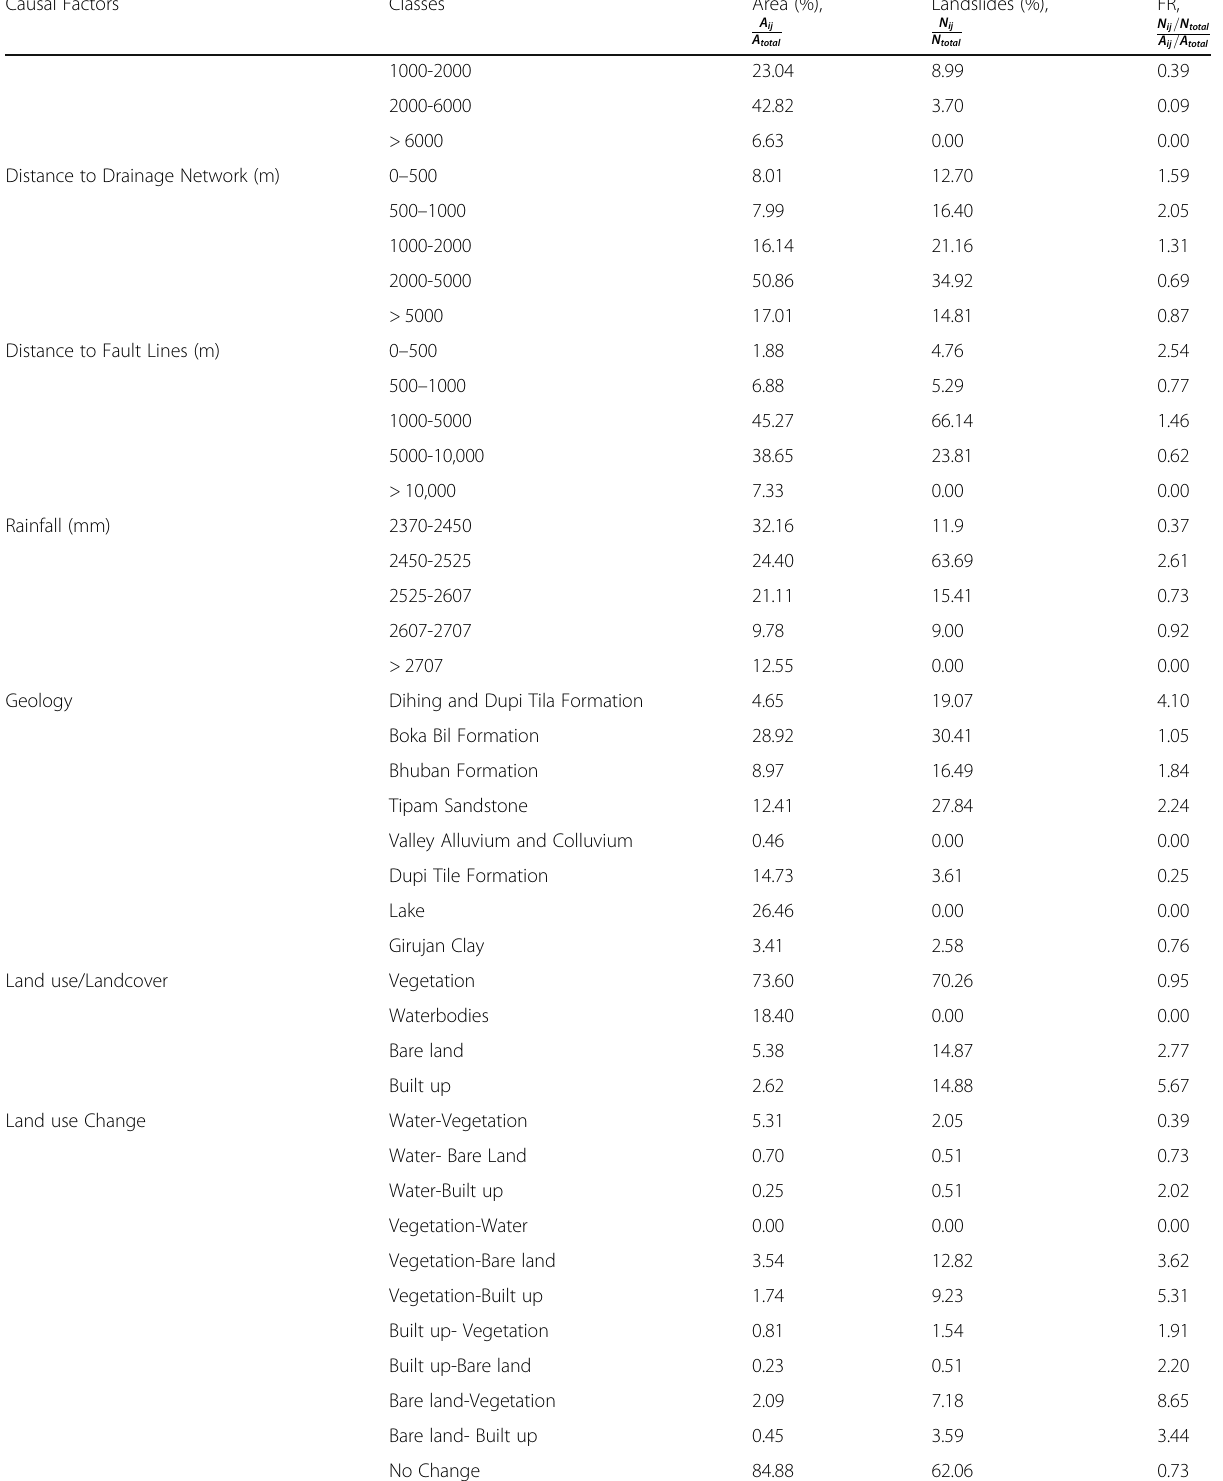
Table 2 Frequency Ratios of Landslide Causal Factors